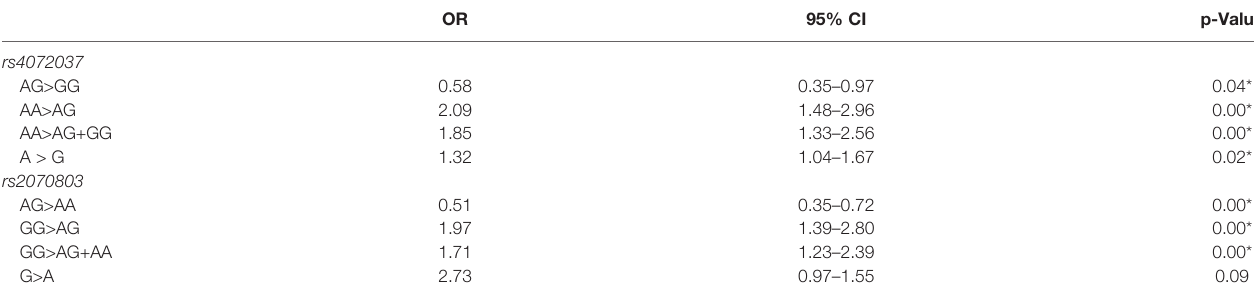
TABLE 5 | Association of the genotypes and alleles of rs4072037 and rs2070803 with the risk of gastric cancer: univariate logistic regression analysis. OR 95% CI